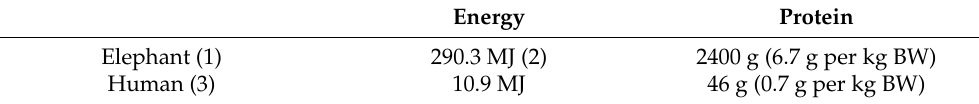
Table 4. Daily energy and protein requirements of elephants and